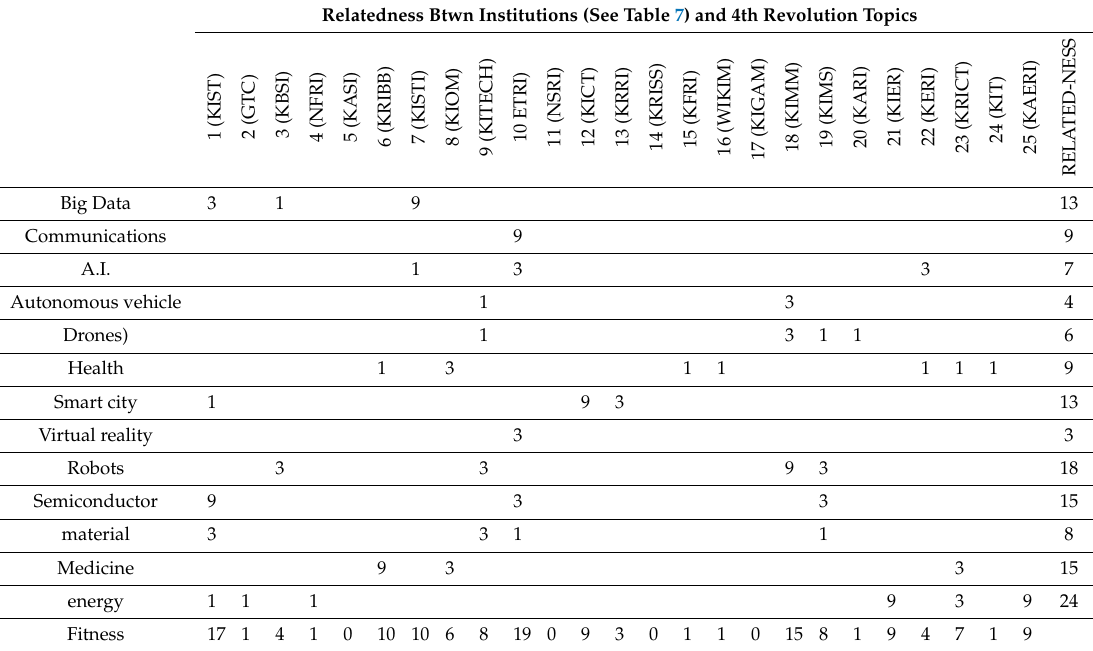
Table 6. Matching between institutions and topics related to the 4th industrial revolution (QFD